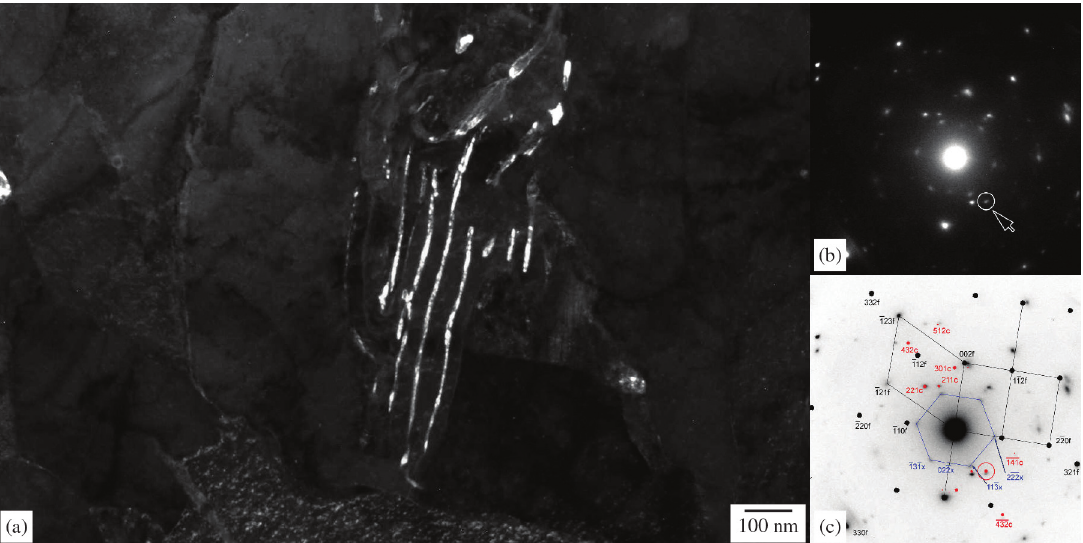
Figure 7. TEM micrograph showing in (a) dark field contrast of cementite lamellae taken from a {221}c reflection and respective electron diffraction pattern in (b). Key diagram in (c) indicates a cementite orientation close to [1